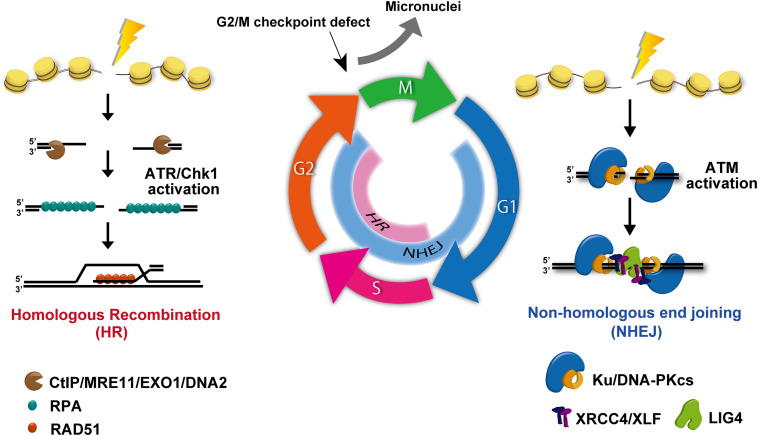
DNA double-strand break (DSB) repair and signal activation. Non-homologous end joining (NHEJ) functions throughout all cell-cycle phases except mitosis. Homologous recombination (HR) becomes active and repairs DSBs only in the S/G2 phase. During repair, ataxia-telangiectasia-mutated (ATM) is activated at un-resected DSB ends, i.e., at the breaks undergoing NHEJ. In addition, ataxia telangiectasia and Rad3-related (ATR) is effectively activated at ssDNA following DSB end resection. Because DSB ends are resected during HR, ATR activation occurs in the S/G2 phase.